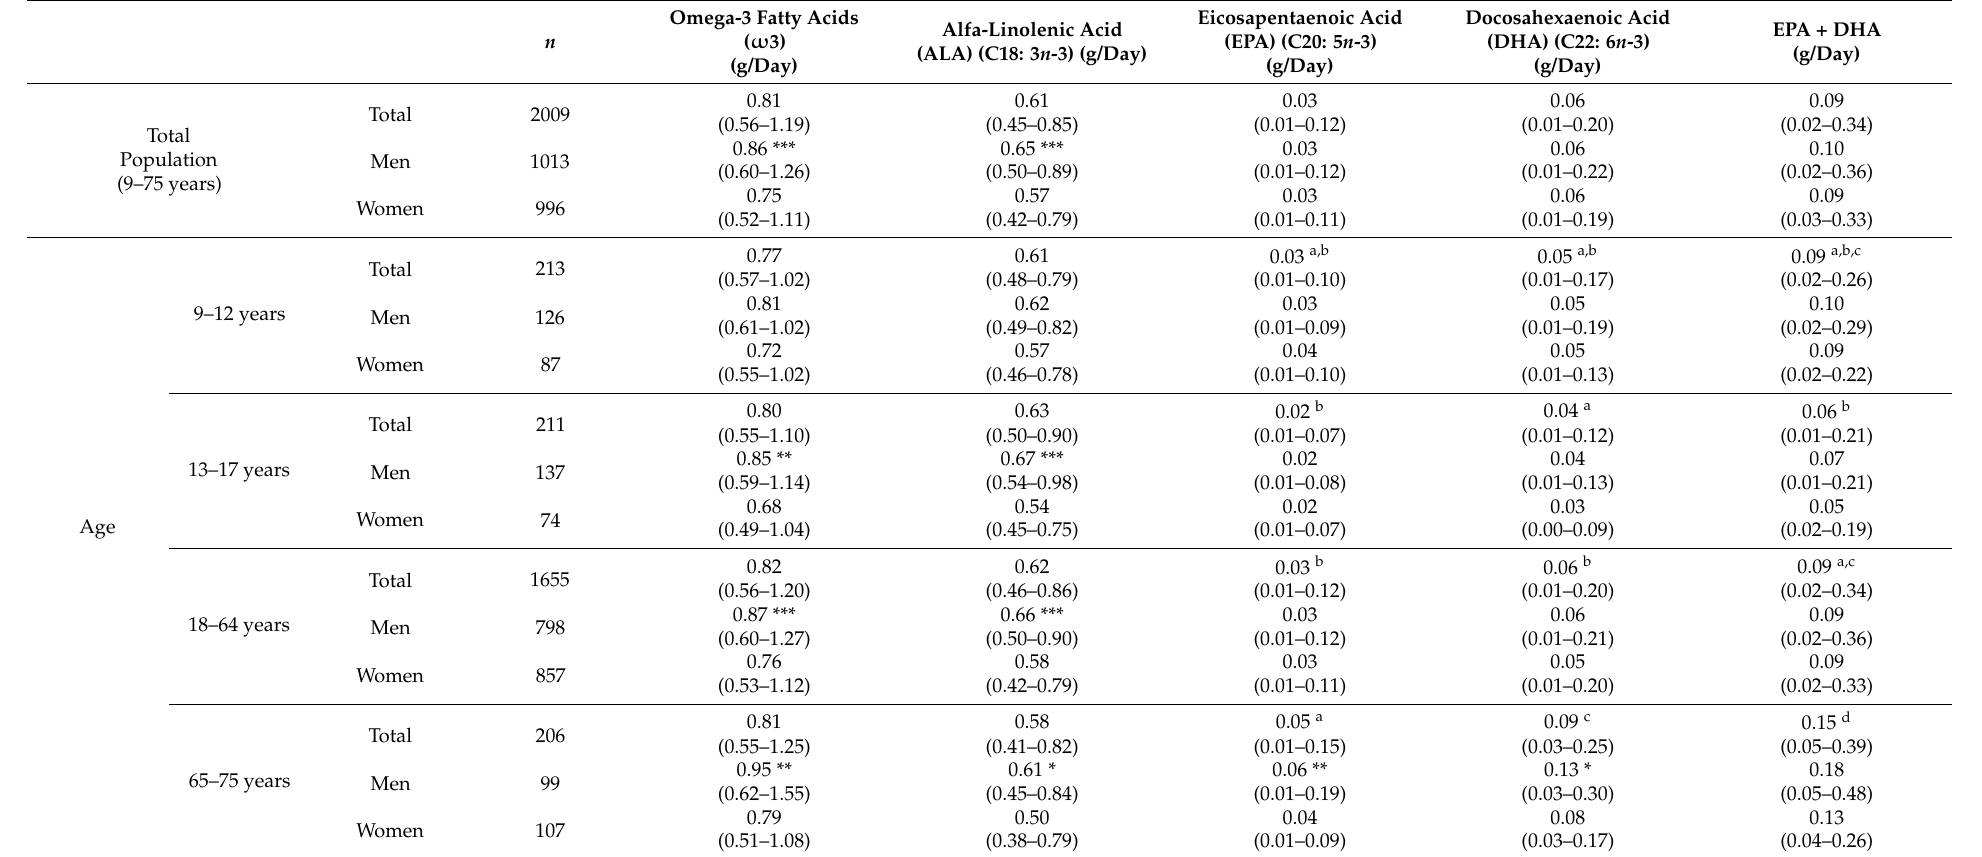
Table 1. Omega-3 fatty acid dietary intake among the ANIBES Study